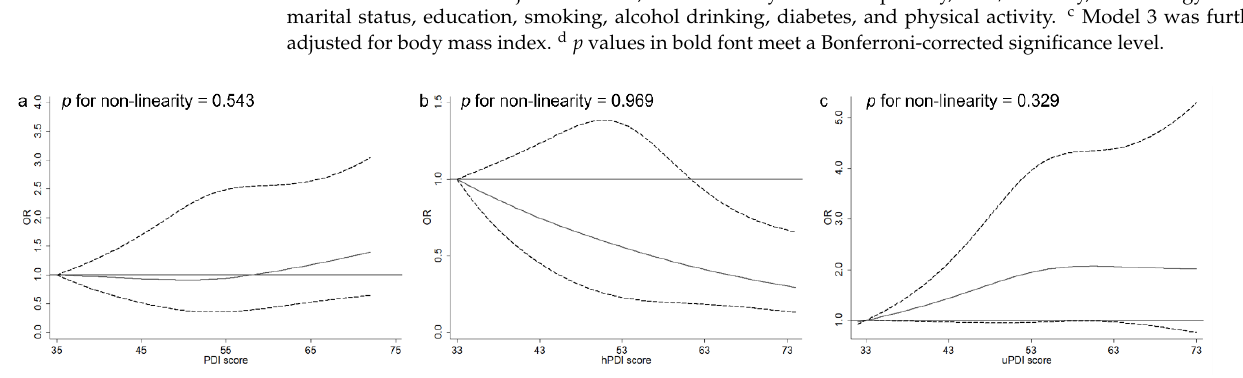
Figure 1. Spline analysis for the association of overall PDI ( a ), hPDI ( b ), uPDI ( c ), with the odds of NAFLD a . hPDI, healthful plant-based diet index; NAFLD, nonalcoholic fatty liver disease; PDI, plant-based diets index; uPDI, unhealthful plant-based diet index. a The models were adjusted for the same covariates listed for model 3 in Table 2.